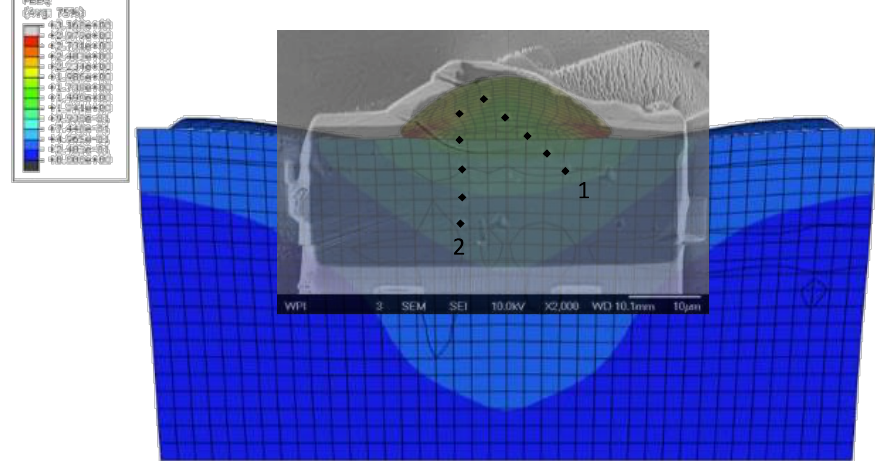
Figure 68: SEM image of nanoindentations overlaid on the output of the single particle impact model. Figure 54. SEM micrograph of nanoindentation residual indentation marks superimposed upon the equivalent plastic strain (PEEQ) output from the FEA single particle impact computation.